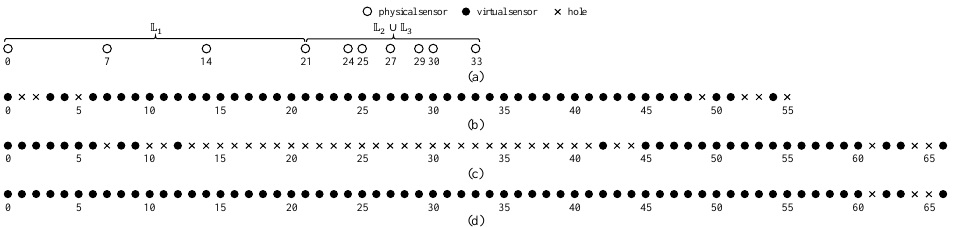
Figure 3. An example of the coprime transformed nested array and its coarrays, where L = 4, M = 3, N = 4. ( a ) Physical array. ( b ) Cross sets ( L 2 ∪ L 3 − L 1 ) ∪ ( L 2 ∪ L 3 + L 1 ) . ( c ) Self sets ( L ∪ L − L ∪ L ) ∪ ( L ∪ L + L ∪ L ) . ( d ) Diff-sum coarray. 2 3 2 3 2 3 2 3 Property 2. The diff-sum coarray of CTNA is continuous in the range [ − l u , l u ] , where l u = 2 ( L − 1 ) ( M + N ) + MN + M + N − 1